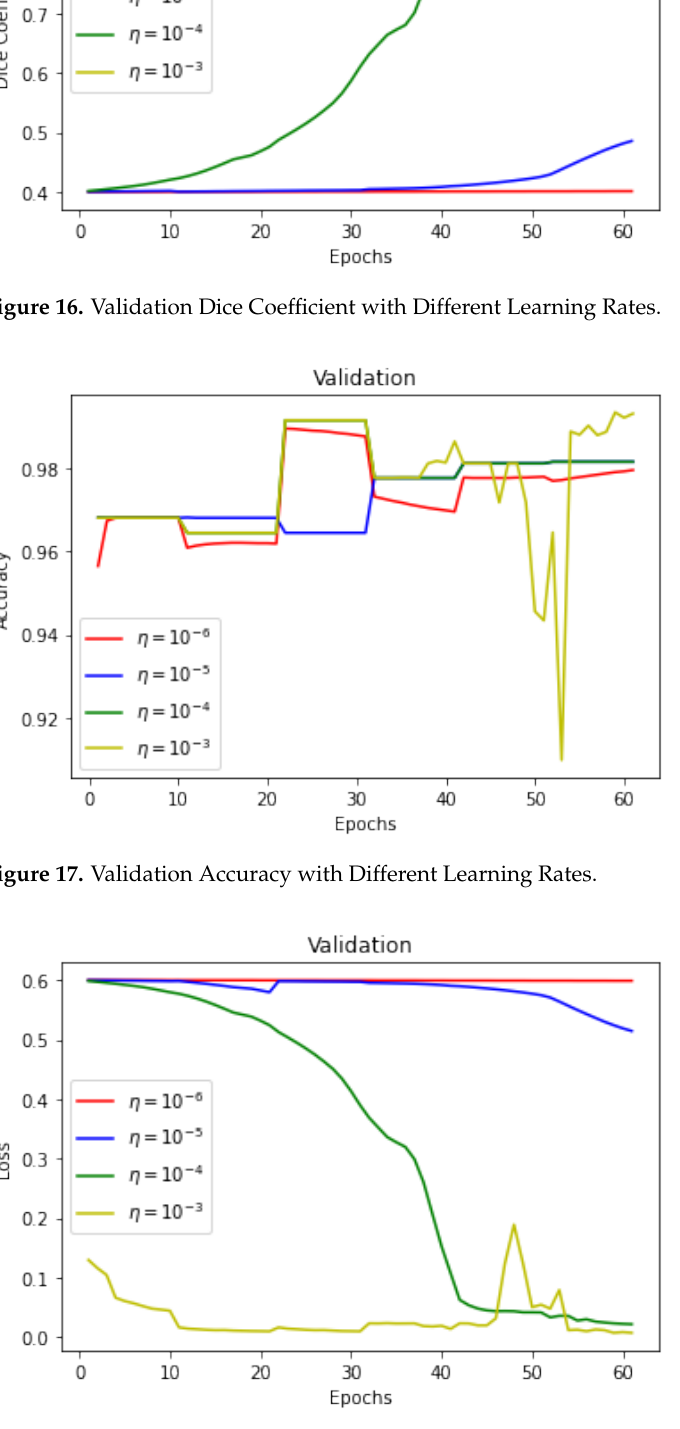
Figure 18. Validation Loss with Different Learning